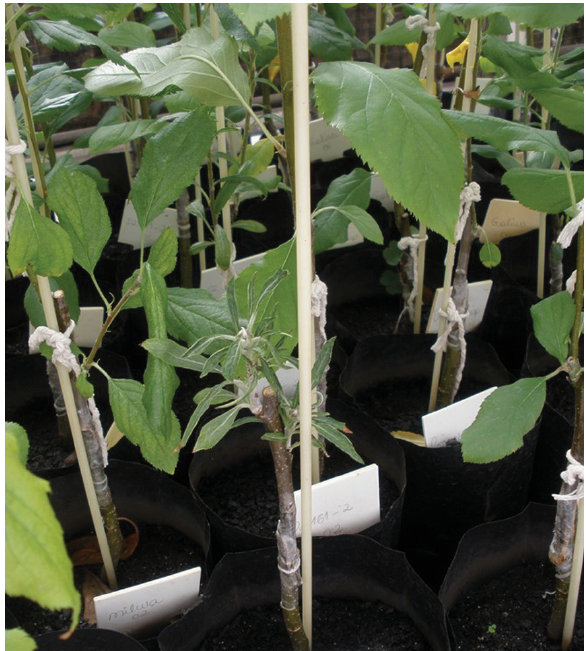
Figure 1. Apple plant with foliar reduction and stunting surrounded by healthy apple